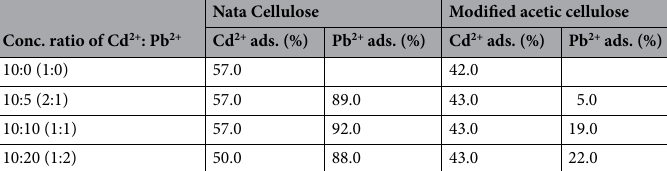
Table 6. Adsorption of Cd 2+ and Pb 2+ on